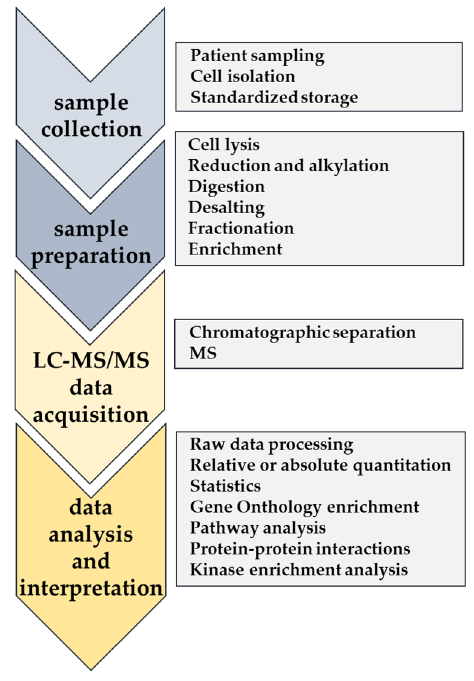
Figure 2. Workflow of standard mass spectrometry (MS)-based proteomics with a description of main tasks at each step.